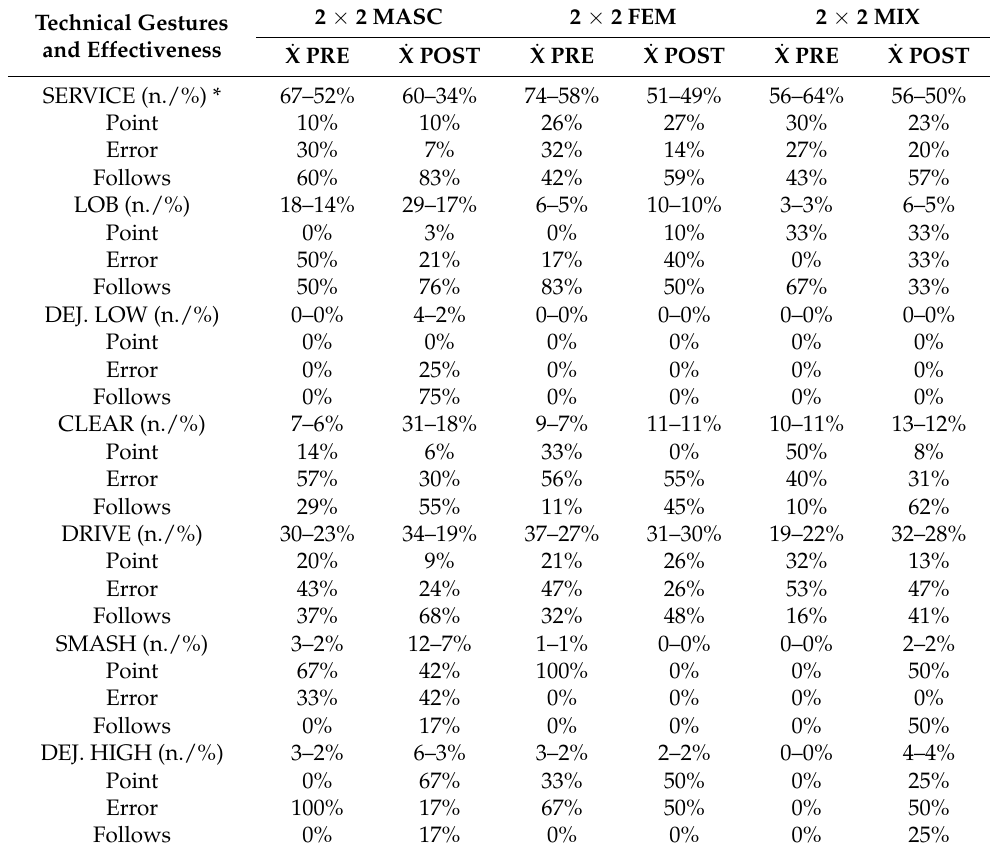
Table 7. Effectiveness and use of AirBadminton technical gestures analysed pre- and post-test. Technical